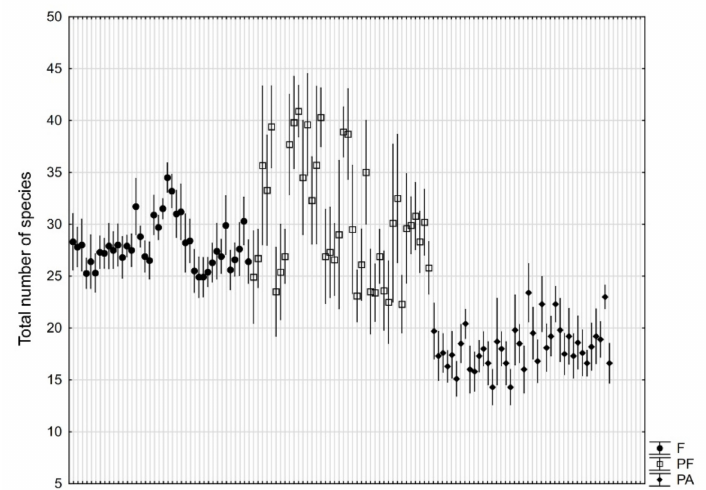
Figure 2. Total number (mean ± 95% confidence interval based on 10 research plots of 100 m 2 ) of plant species in natural forests (F), manor parks adjacent to forests (PF), and manor parks not adjacent to forests (PA).